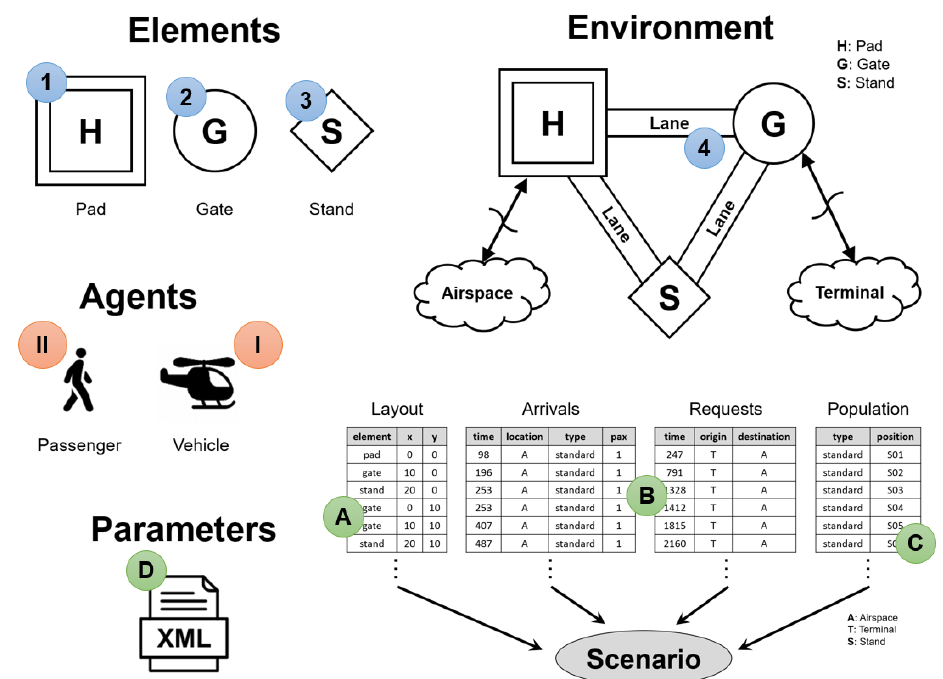
Figure 1. Depiction of elements, agents and environment of the agent-based simulation framework for vertiport operations; further including inputs needed for one simulation